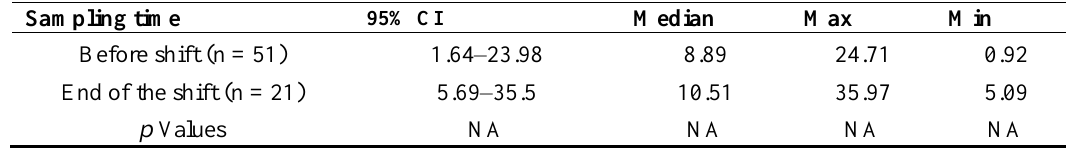
Table 4. The comparison of perchlorate concentration in the urine for occupational workers at the different work shifts a (µg